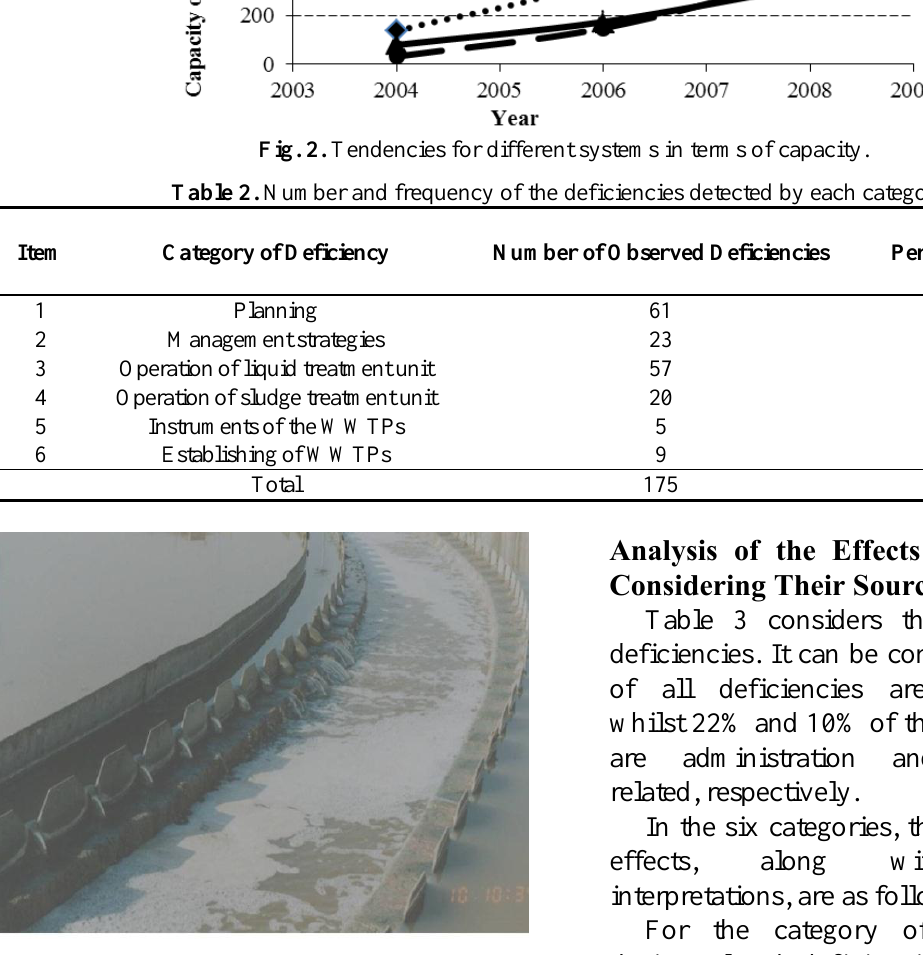
Fig. 3. Sample of unsuitable construction work (unbalanced V-notch) (Amirtaimour,